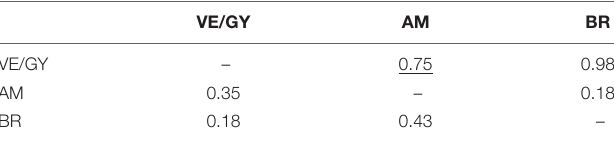
TABLE 2 | Pairwise population matrix of R ST and F ST distance values for manatee genotypes across 10 microsatellite loci.